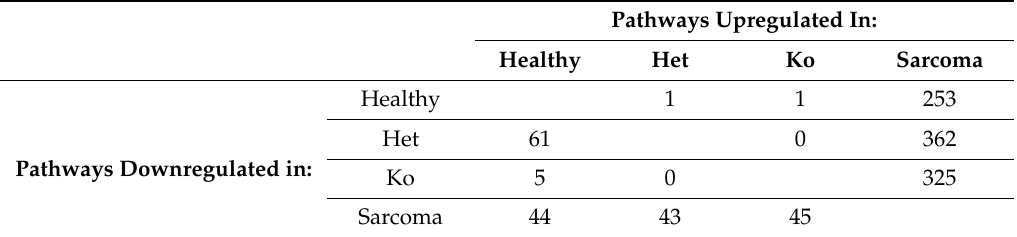
Figure 5. Gene set enrichment results of comparisons between the sarcoma group, healthy, heterozygous and homozygous Tp53 knockout groups. ( a ) Enrichment plots of the Reactome cell cycle gene set that showed significant upregulation in the sarcoma group in comparison to the homozygous (left panel), heterozygous (middle panel) and healthy (right panel) groups. ( b ) Enrichment plots of the Reactome Kinesins gene set that showed significant upregulation in the sarcoma group in comparison to the homozygous (left panel), heterozygous (middle panel) and healthy (right panel) groups. ( c ) Enrichment plots of the Reactome TCA cycle and respiratory electron transport gene set that showed significant downregulation in the sarcoma group in comparison to the homozygous (left panel), heterozygous (middle panel) and healthy (right panel) groups. Table 2. Number of gene sets significantly enriched in pairwise comparisons in GSEA.